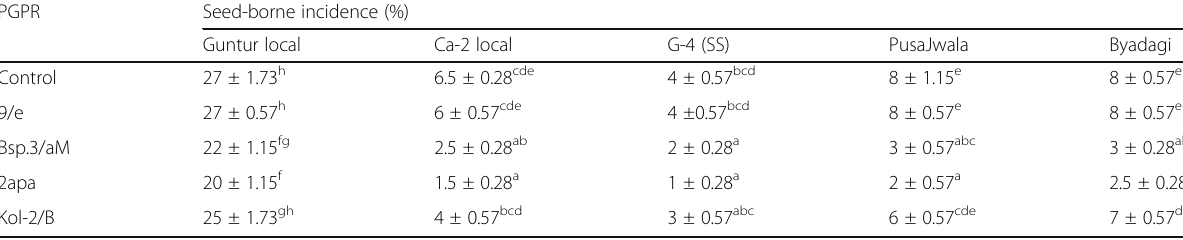
Table 2 Efficacy of seed biopriming on seed-borne incidence